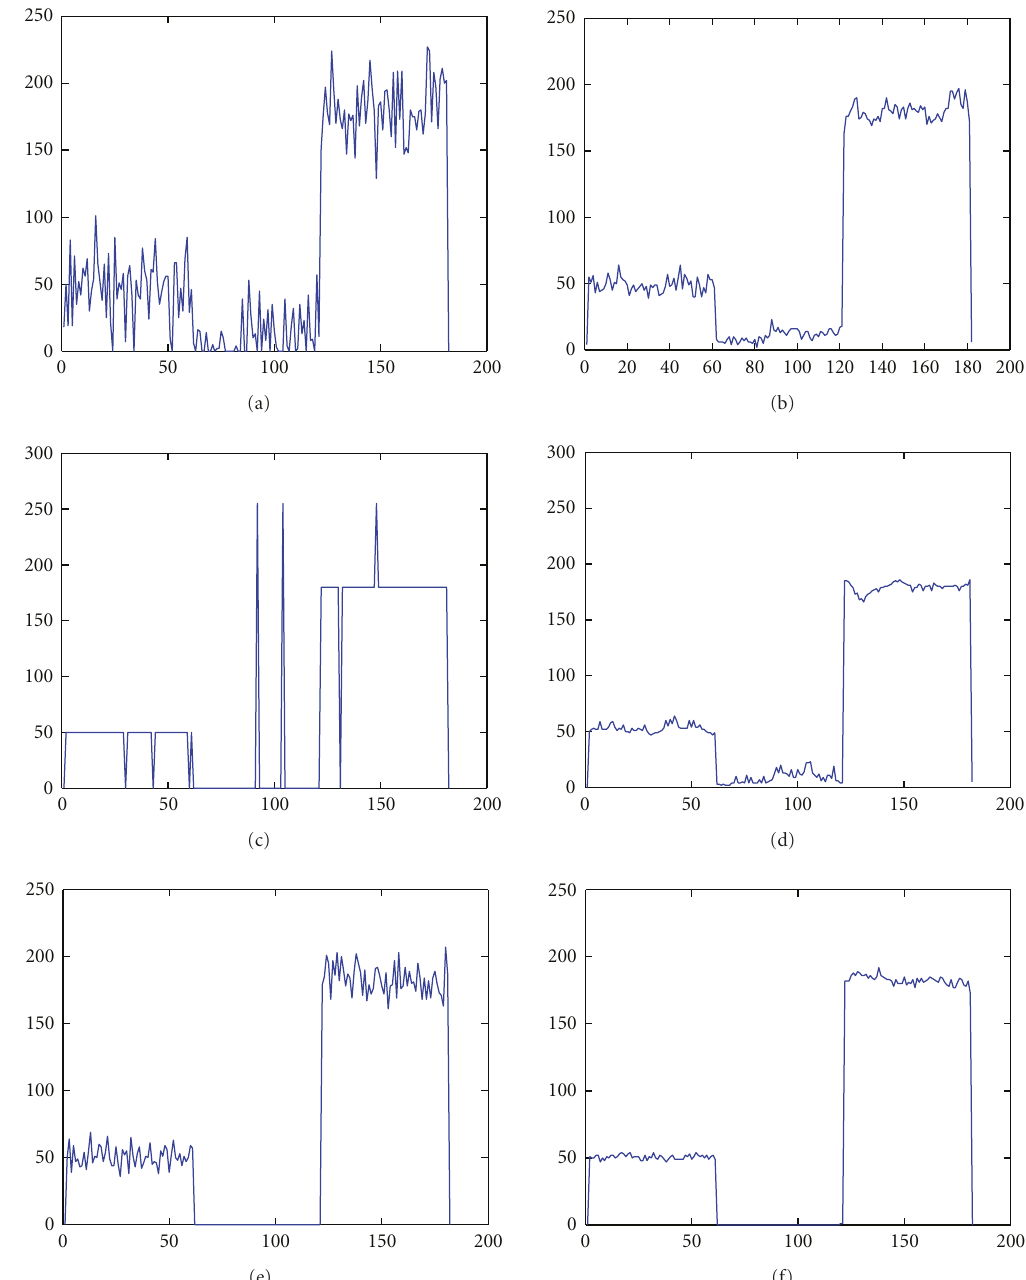
Figure 14: The 20th row of u ( x , y ) of the image “Nine Square Regions” with the various noise. (a) Gaussian noise, (c) Salt and Pepper noise, (e) Poisson noise. The denoised results are, respectively, (b), (d), and (f)